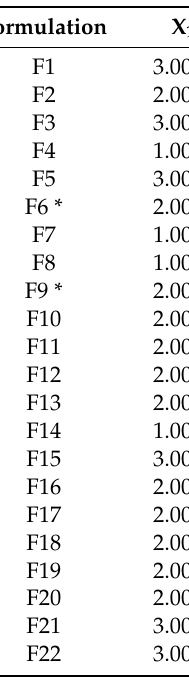
Table 5. Box Behnken design